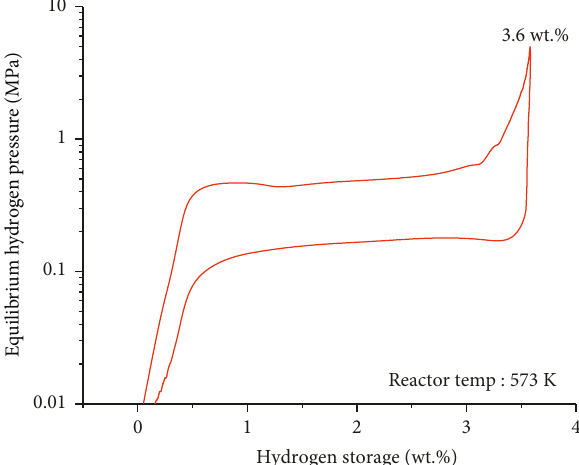
Figure 9: PCTcurve of Mg ball milling.